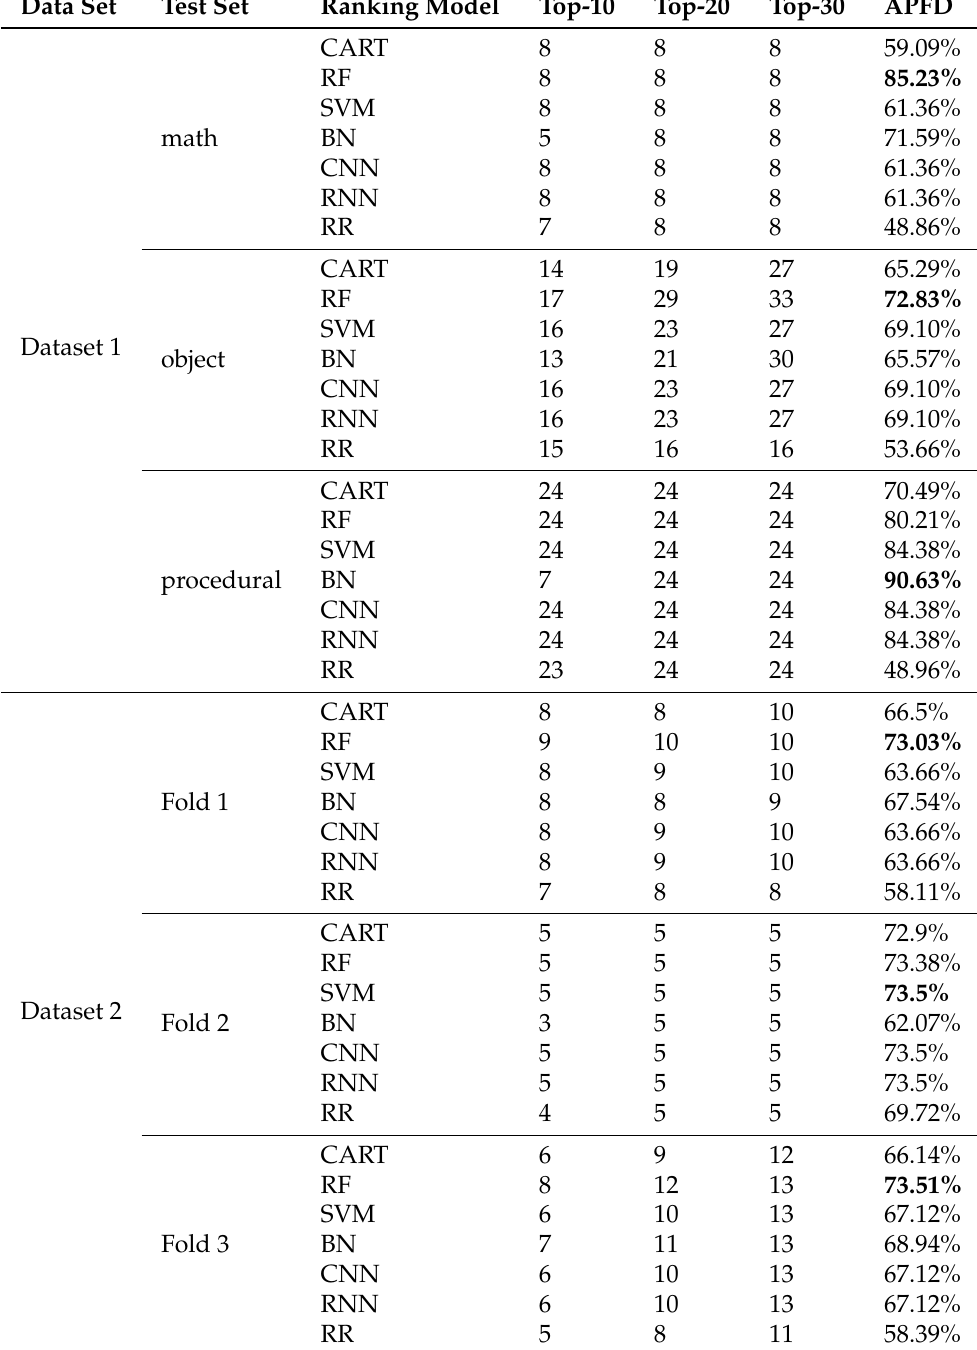
Table 5. Evaluation results of the six models and the baseline of random rankings. We show the result in top-10, top-20, top-30, and the APFD. The top- k metric indicates the number of defects that are found by the top k test cases in an ordered sequence of test cases. The zero value in the evaluation metrics means that no defective method is detected by the test